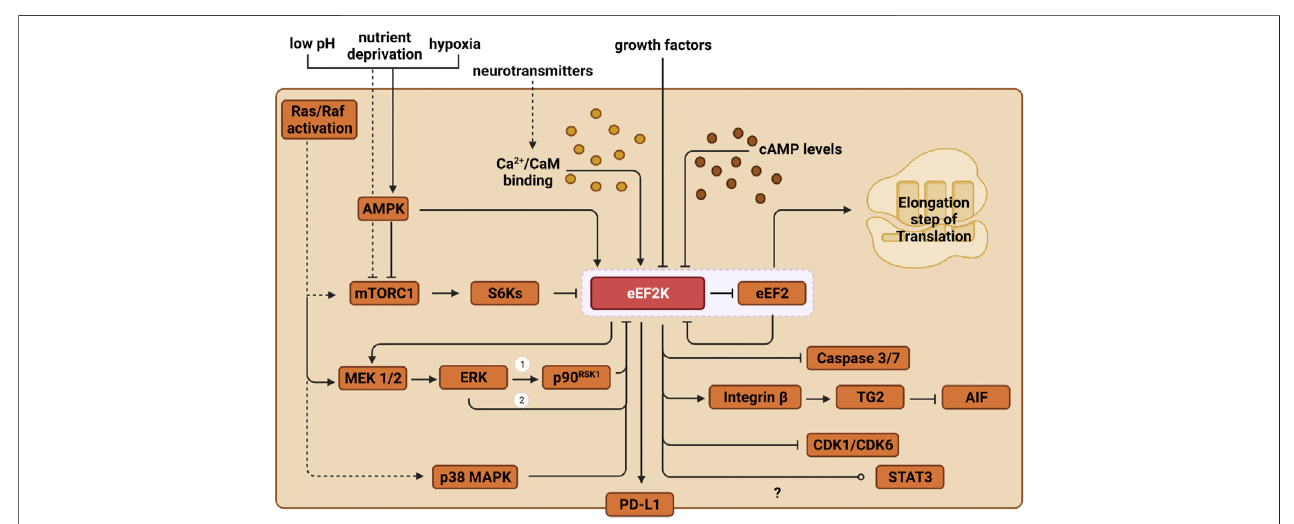
FIGURE2| OutlinedarethevariouspathwaysthroughwhicheEF2Kisregulatedandhowitultimatelyimpactsproteinsynthesis.Solidlinesdepictdirectpathways, and indirectpathwaysareshown withdashed lines.eEF2istheonly substratefor eEF2K, shown inthe redbox. ERK regulateseEF2Kin twoways:1) direct inhibition on eEF2K and 2) the induction of p90 RSK1 . The regulation of STAT3 by eEF2K is under debate, but current evidence shows eEF2K inhibits STAT3 in lung cancer and activates it in liver